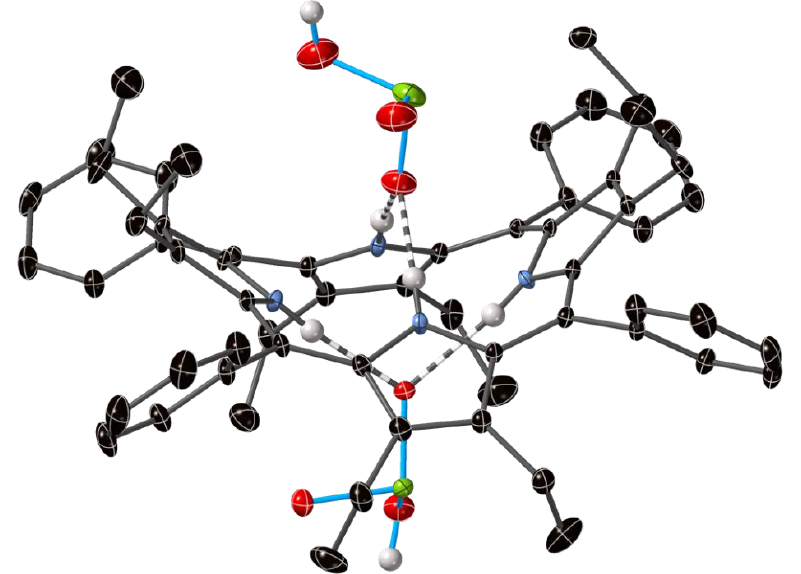
Figure 4. The “isolated” molecular cluster resulting from a 1:2 ratio of dication to monoanion in the structure of [H 4 1 ](HSe IV O 3 ) 2 · (CH 3 OSe IV O 2 H) · 3(CH 3 OH) (compound 6 ); solvates and C-bound H structure of [H 4 1 ](HSe IV O 3 ) 2 ·(CH 3 OSe IV O 2 H)·3(CH 3 OH) (compound 6 ); solvates and C-bound H at- atoms omitted for oms omitted for clarity.